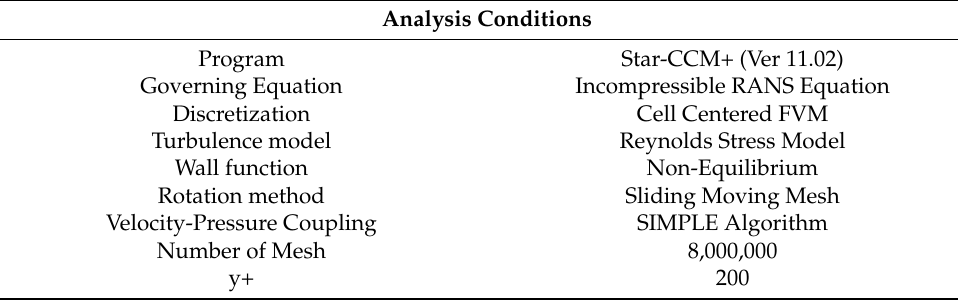
Table 3. Computational conditions for the analysis of the 1800 TEU container ship.